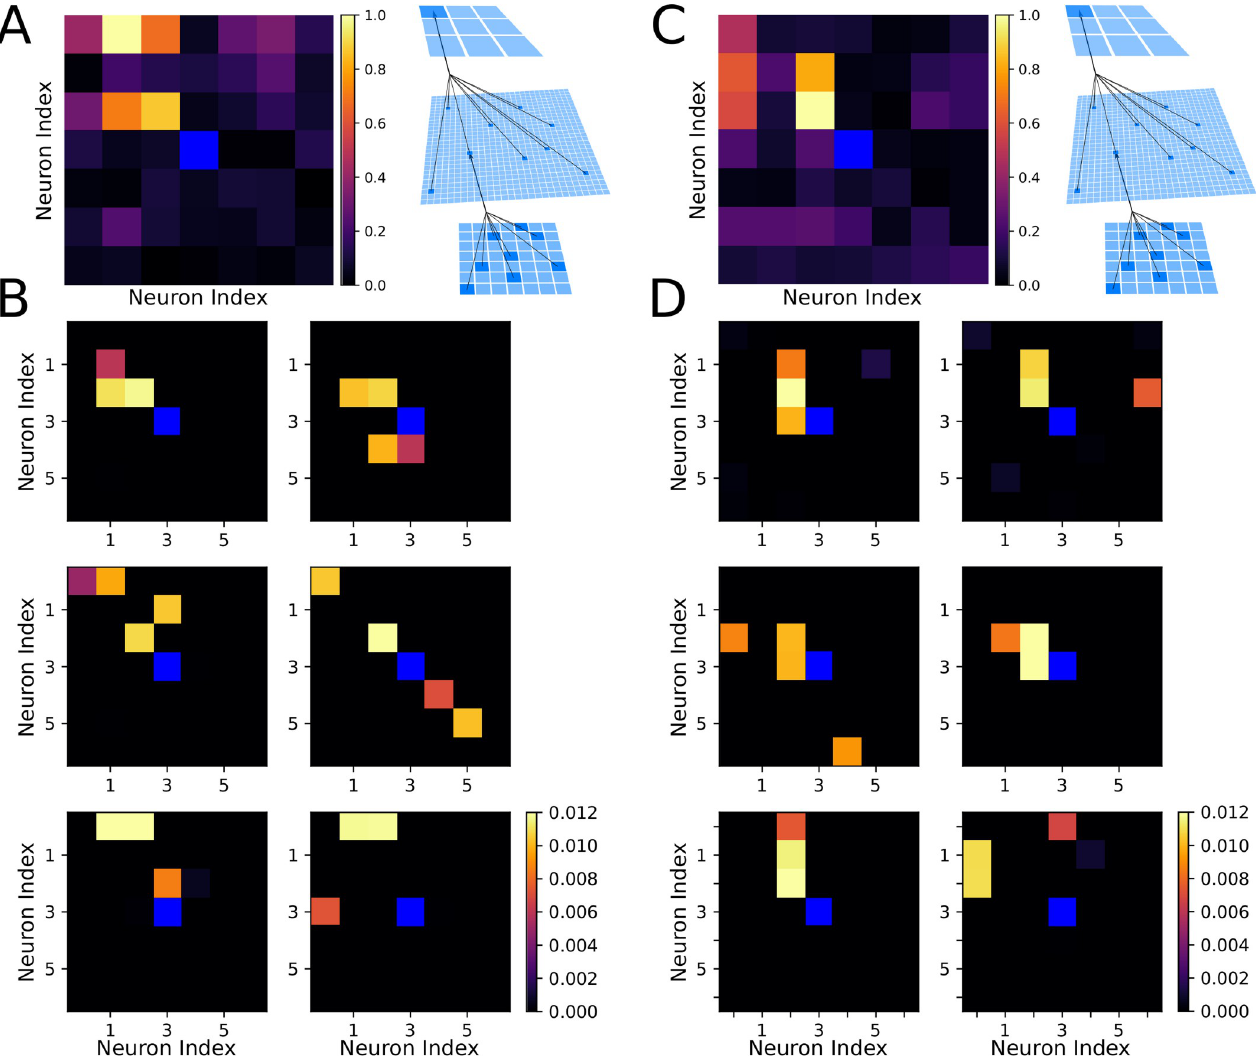
Fig 2. Receptive fields of output and hidden layer neurons determine the agent behavior. (A) Left, Receptive field of the output layer neuron controlling movement to the upper-left direction following training on Task 1. This neuron can be seen to selectively respond to horizontal orientations in the upper-left quadrant of the visual field. Right, Schematic of connections between layers. (B) Examples of receptive fields of hidden layer neurons which synapse strongly onto the output neuron from (A) after training on Task 1. (C) The same as shown in (A) except following training on Task 2. The upper-left decision neuron can be seen to selectively respond to vertical orientations in the upper-left quadrant of the visual field. (D) The same as shown in (B) except following training on Task